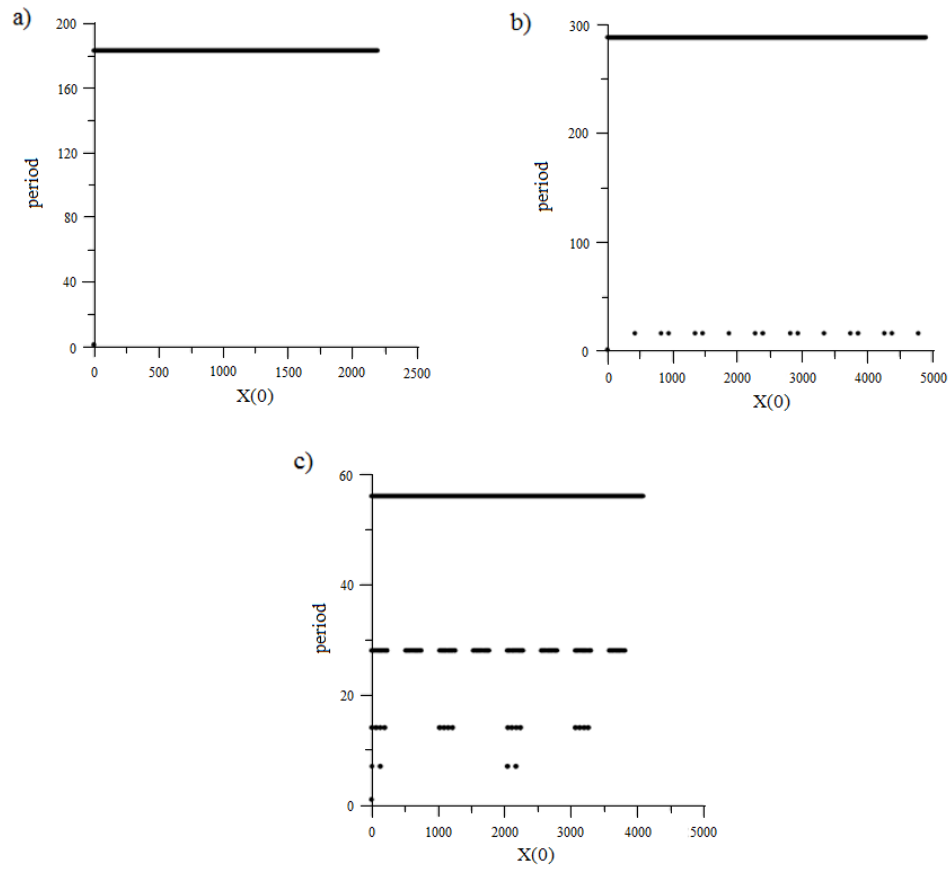
Figure 2. Dependences of AFG repetition periods on the key.